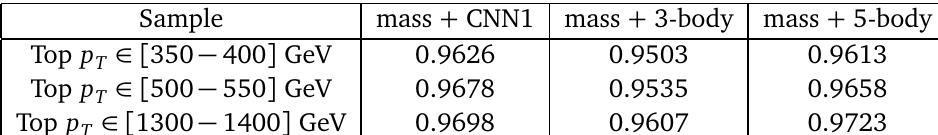
Table 2: The area-under-curve (AUC) values for a selection of our ROC curves. Larger values are better and AUC = 1 corresponds to perfect signal and background discrim- ination.